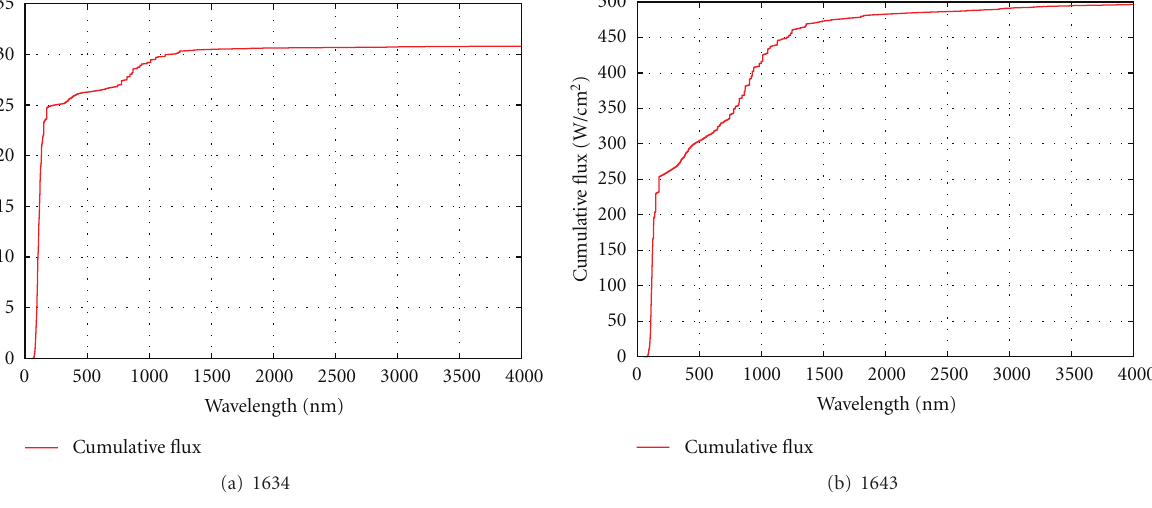
Figure 5: Spectral range analysis.